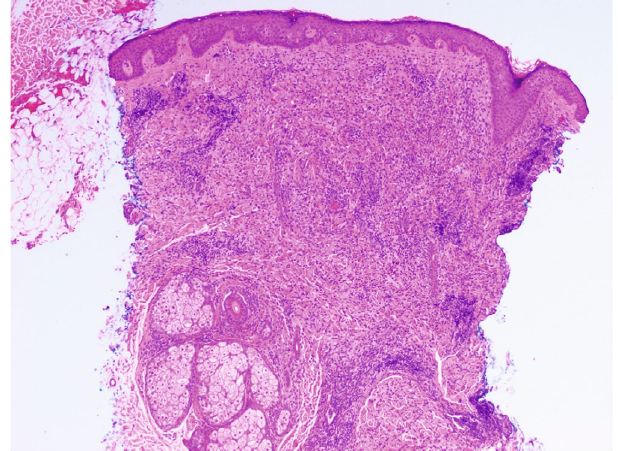
Figure 2: Micrograph of the forehead lesions demonstrating intense dermal-based in fi ltrate of foamy macrophages with sparing of skin adnexa. H&E × 40.